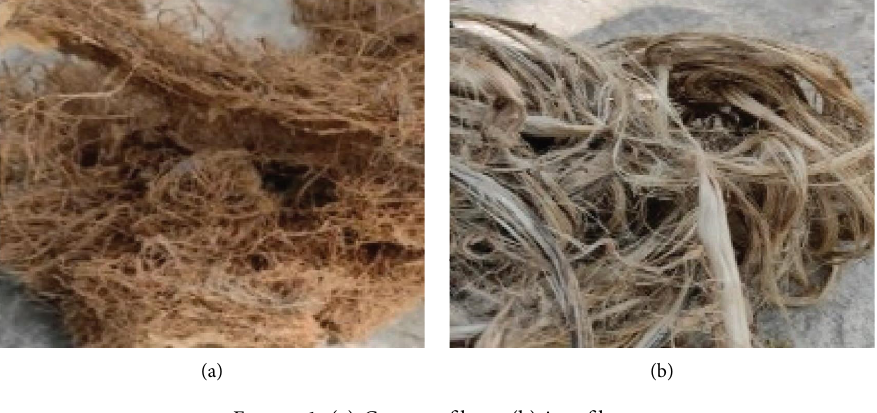
Figure 1: (a) Coconut fbres; (b) jute